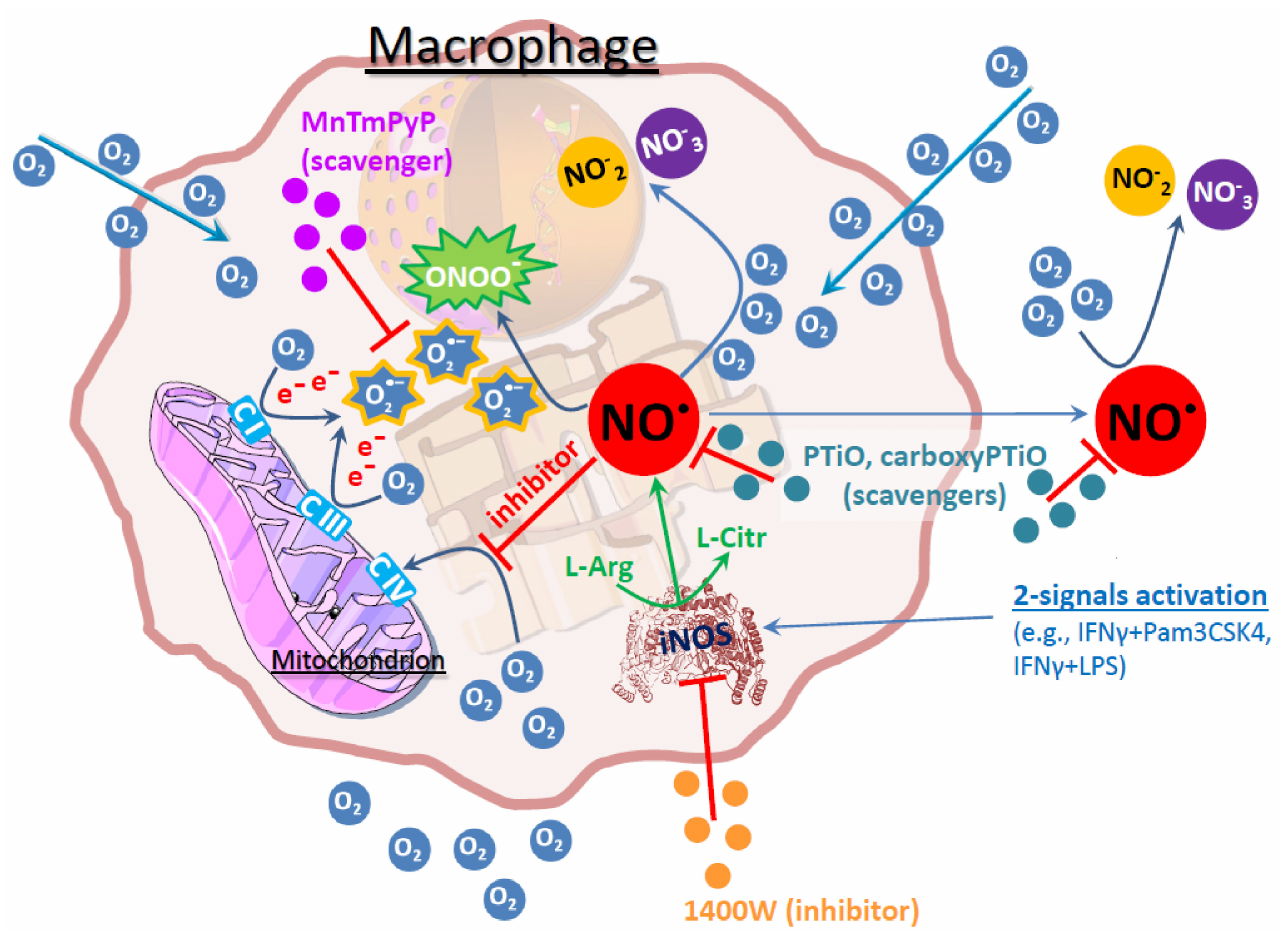
Figure 4. Overview of the processes affecting oxygen consumption in M(2-signals) macrophages. The main source of oxygen consumption in macrophages (as in all cells) is the terminal electron (e − ) donor at ETC complex IV (heme a3-Cu B center). Upon 2-signals activation (e.g., IFN γ + LPS or IFN γ + Pam3CSK4), the macrophages express iNOS, leading to production of NO • . NO • reversibly inhibits the O 2 attachment to complex IV, causing even higher electron leak from the ETC. These electrons can reduce O 2 to O 2 •− , which then can bind with NO • and produce ONOO − . Alternatively, NO • can react with O 2 and produce NO 2 ¯ and/or NO 3 ¯ . Inhibitors [1400 W (iNOS)] and scavengers [PTiO/carboxyPTiO (NO • ), MnTmPyP (O 2 •− )] on various levels (indicated with red lines) hamper the production of these free radicals, leading to the partial recovery of